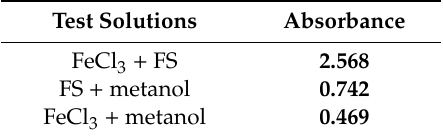
Table 3. Absorbances of test solutions at 495 Table 3 . Absorbances of test solutions at 495 nm. Table 3 . Absorbances of test solutions at 495 nm.